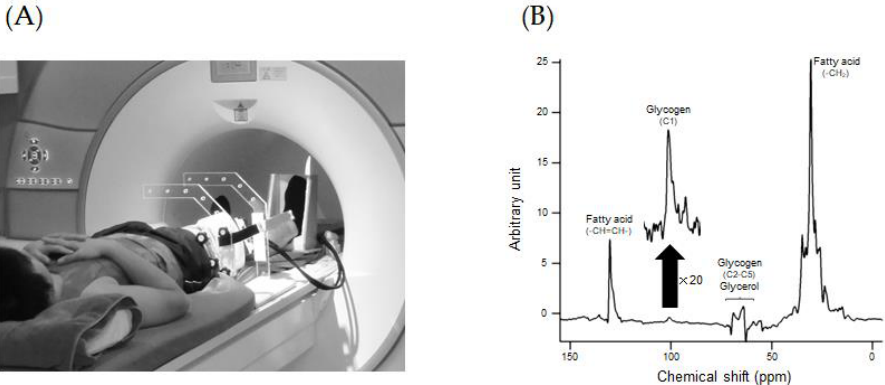
Figure 1. View of 13 C MRS measurement of the thigh muscle ( A ) and representative 13 C MRS spectrum of the muscle ( B ).